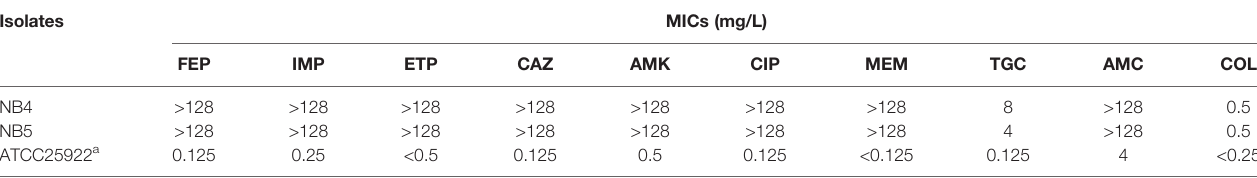
TABLE 1 | Antibiotic susceptibility of CRKP strain NB4 and NB5. Isolates MICs